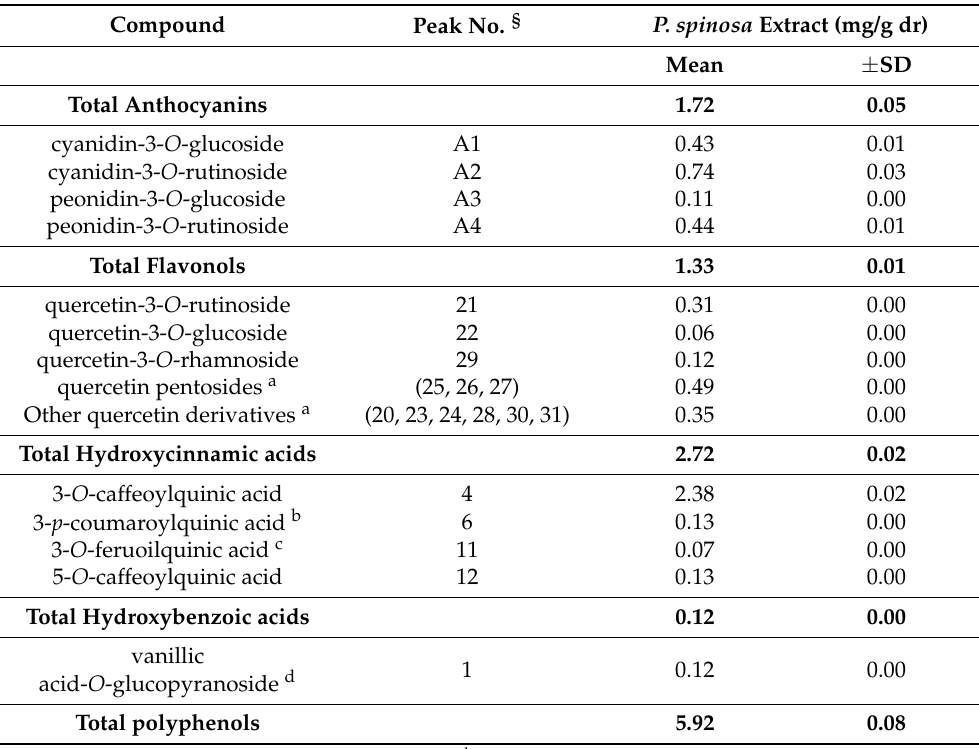
Table 3. Concentration of targeted phenolic compounds detected in P. spinosa fruit extract (mg/g of dried extract (dr), mean ± SD; n =